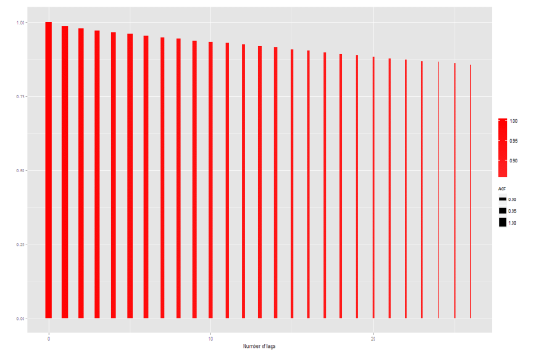
Figure 4 Autocorrelation expolarity plot.